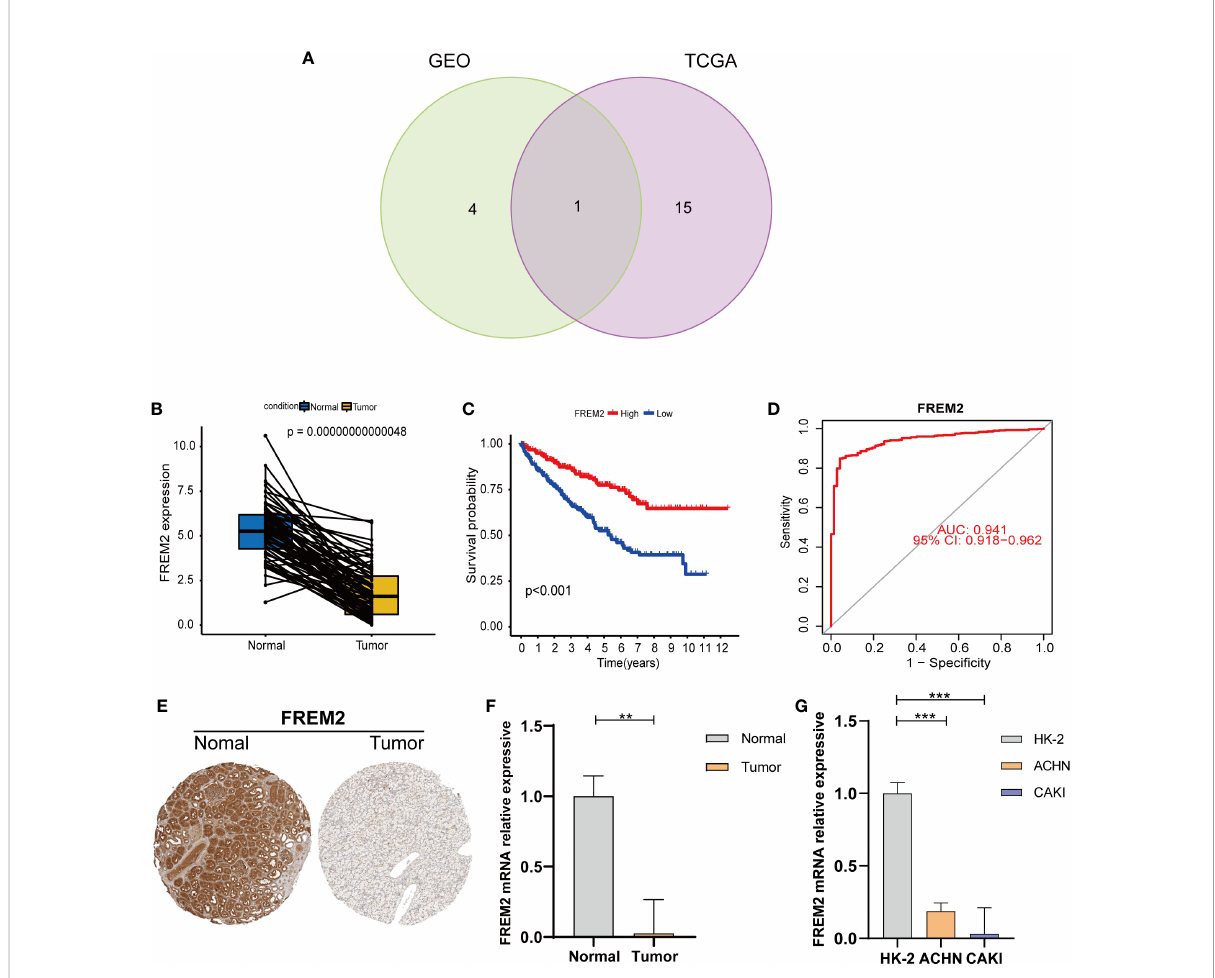
FIGURE 9 The prognostic BMGs were veri fi ed by uni-Cox-reg analysis. (A) Uni-Cox-reg analysis and the intersection of BMGs in the TCGA and GEO cohorts. (B) Paired differentiation analysis of FREM2 expression in cancerous and normal specimens from the same patient ( P = 0.00000000000048, by the WRS test). (C) Various FREM2 expression levels were utilized to carry out survival analysis. Patients were clari fi ed into high or low expression levels on the basis of the median expression level ( P < 0.001 by the log-rank test). (D) ROC curves were plotted to evaluate the FREM2 ’ s most accurate predicting ability. (E) Immunohistochemistry of FREM2 in normal and tumor tissues of the kidney. (F) The qRT-PCR fi ndings of FREM2 in cancerous and normal kidney specimens ( P< 0.01). (G) The qRT-PCR fi ndings of FREM2 in renal cell lines. ** p < 0.01 and *** p <